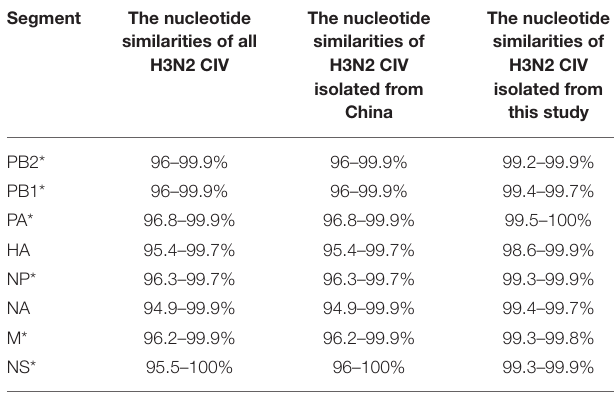
TABLE 3 | The nucleotide similarities of complete genome sequences of H3N2 CIV strains.